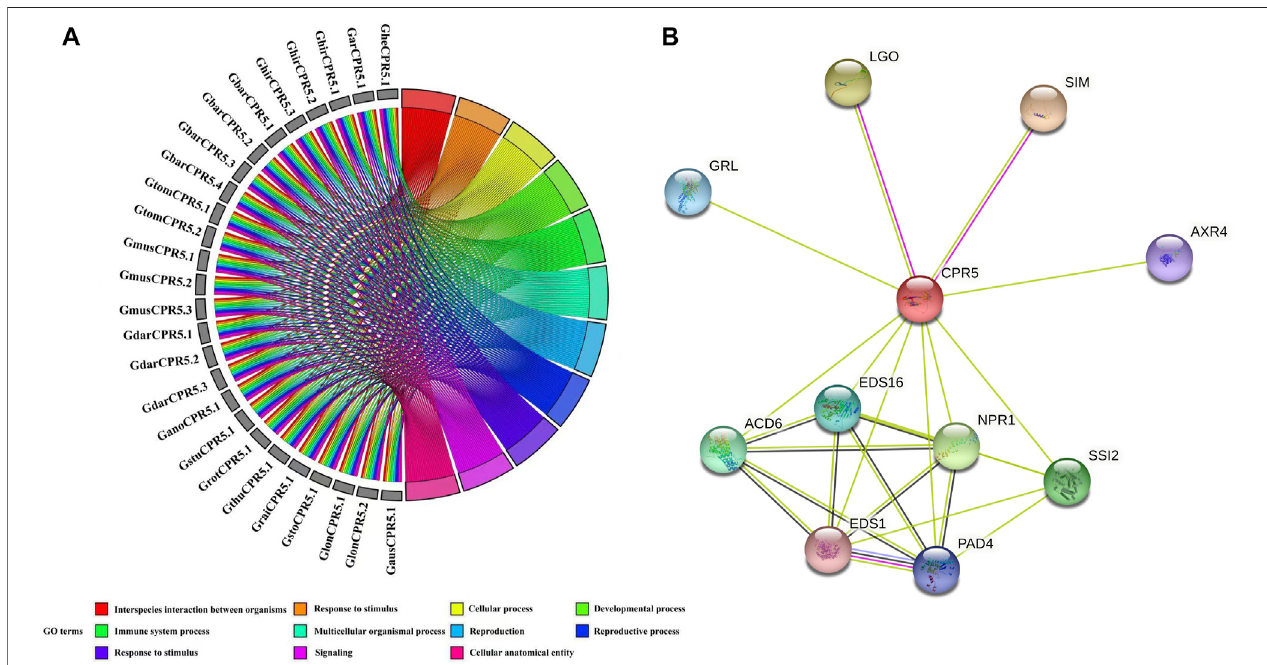
FIGURE 6 | Gene ontology and protein-protein network analysis of CPR5 . (A)- Gene ontology analysis of CPR5 genes. (B)- Protein-protein analysis of CPR5 in Arabidopsis .Colorednodes: queryproteinsand fi rstshell ofinteractors.Redlines:genefusions. Greenlines:geneneighborhood.Blacklines:co-expression.Bluelines: gene